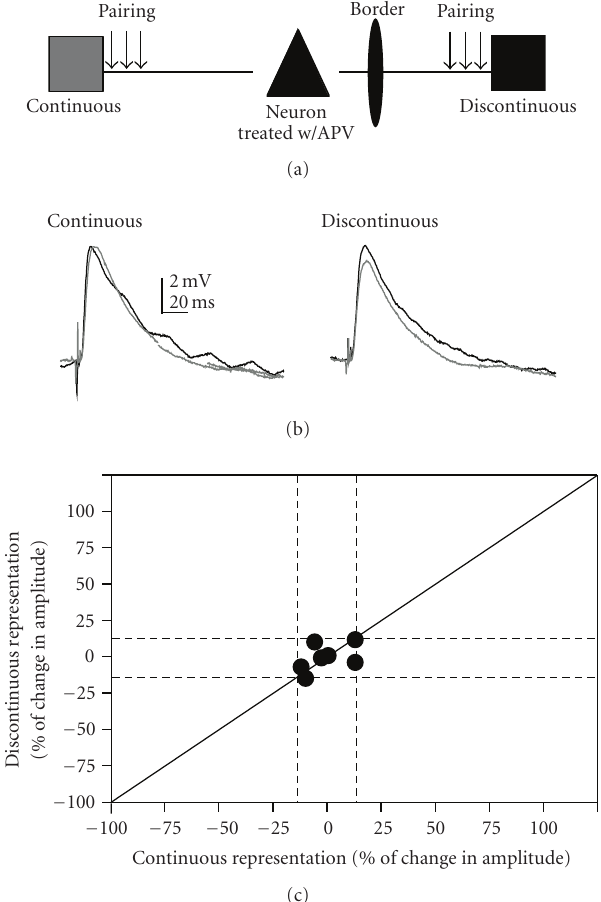
Figure 5: APV blocks pairing induced LTP. (a) Schematic of the two-pathway pairing paradigm. (b) Example responses from a cell that was treated with APV; gray traces are averaged baseline PSPs. Black traces are averaged traces 20 minutes postpairing. Traces are averaged over 5 minutes (15 traces) for both pre- and postpairing PSPs. No enhancement occurred following pairing of both con- tinuous representation and discontinuous representation pathways. (c) Change in PSP amplitude for the continuous representation pathway plotted against discontinuous representation for each cell that received APV and both pathway pairing. Solid diagonal line depicts slope of one. Dashed lines depict 15% above and below no